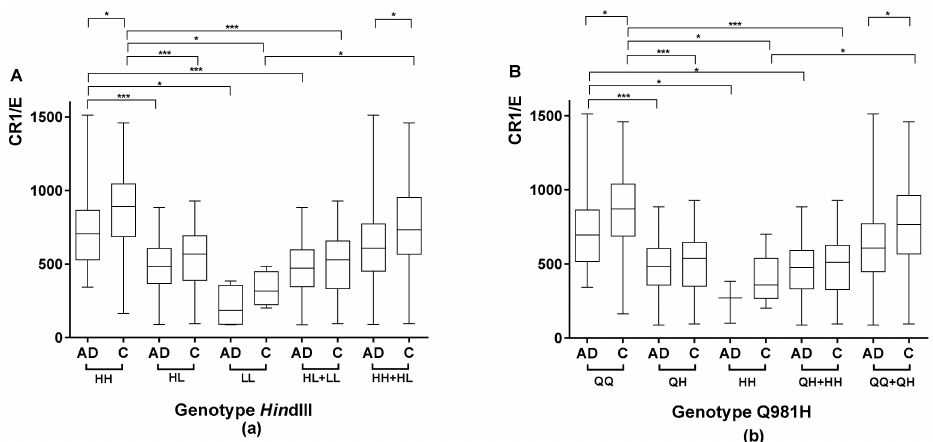
Figure 1. Comparison of the mean number of complement receptor 1 per erythrocyte (CR1/E) according to CR1 density polymorphisms in Alzheimer’s disease (AD) patients and/or controls. Box plots of CR1/E are shown. The upper and lower limits of the boxes, and the middle line across the boxes indicate the 75th and 25th percentiles, and the median, respectively. The upper and lower horizontal bars indicate the maximum and minimum values, respectively. Wilcoxon’s rank test was used to compare CR1 density among AD patients or among controls according to genotype for non-normally distributed variables. The Mann-Whitney U test was used to compare AD patients with controls according to genotype for non-normally distributed variables, and the Student’s t -test was used for normally distributed variables; * p < 0.01, ** p < 0.001, and *** p < 0.0001. ( a ) Comparison of the mean number of CR1/E according to Hin dIII polymorphisms in AD patients and/or controls. ( b ) Comparison of the mean number of CR1/E according to Q981H polymorphisms in AD patients and/or